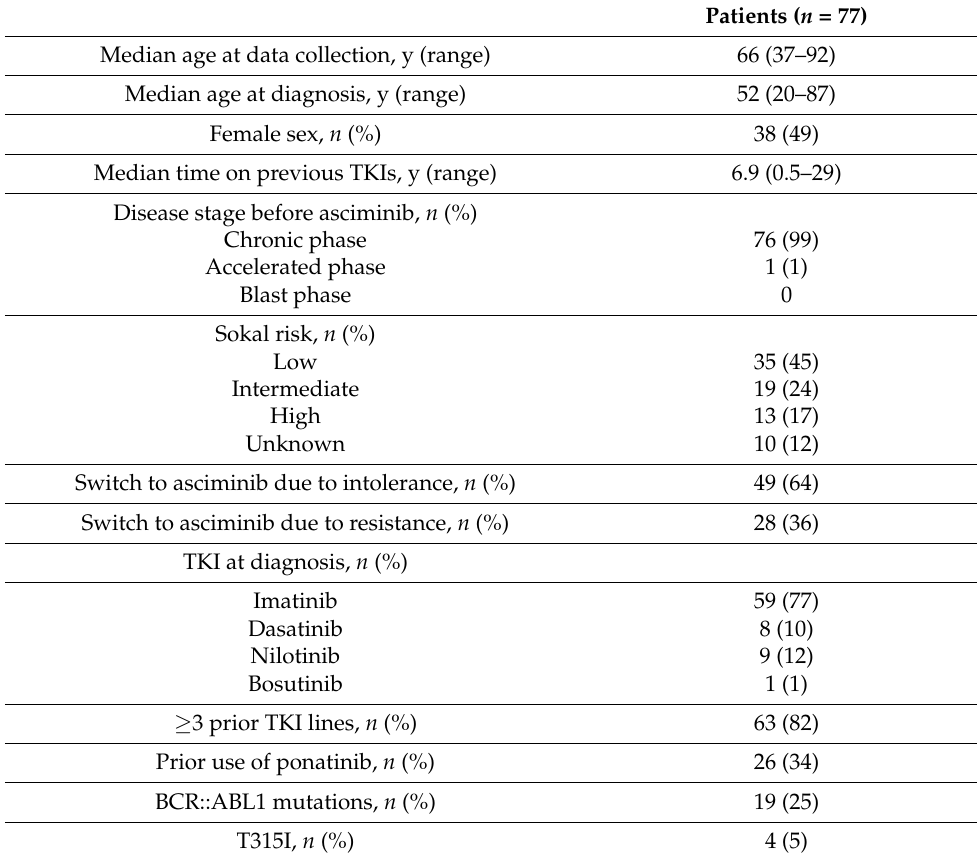
Table 1. Baseline characteristics of the